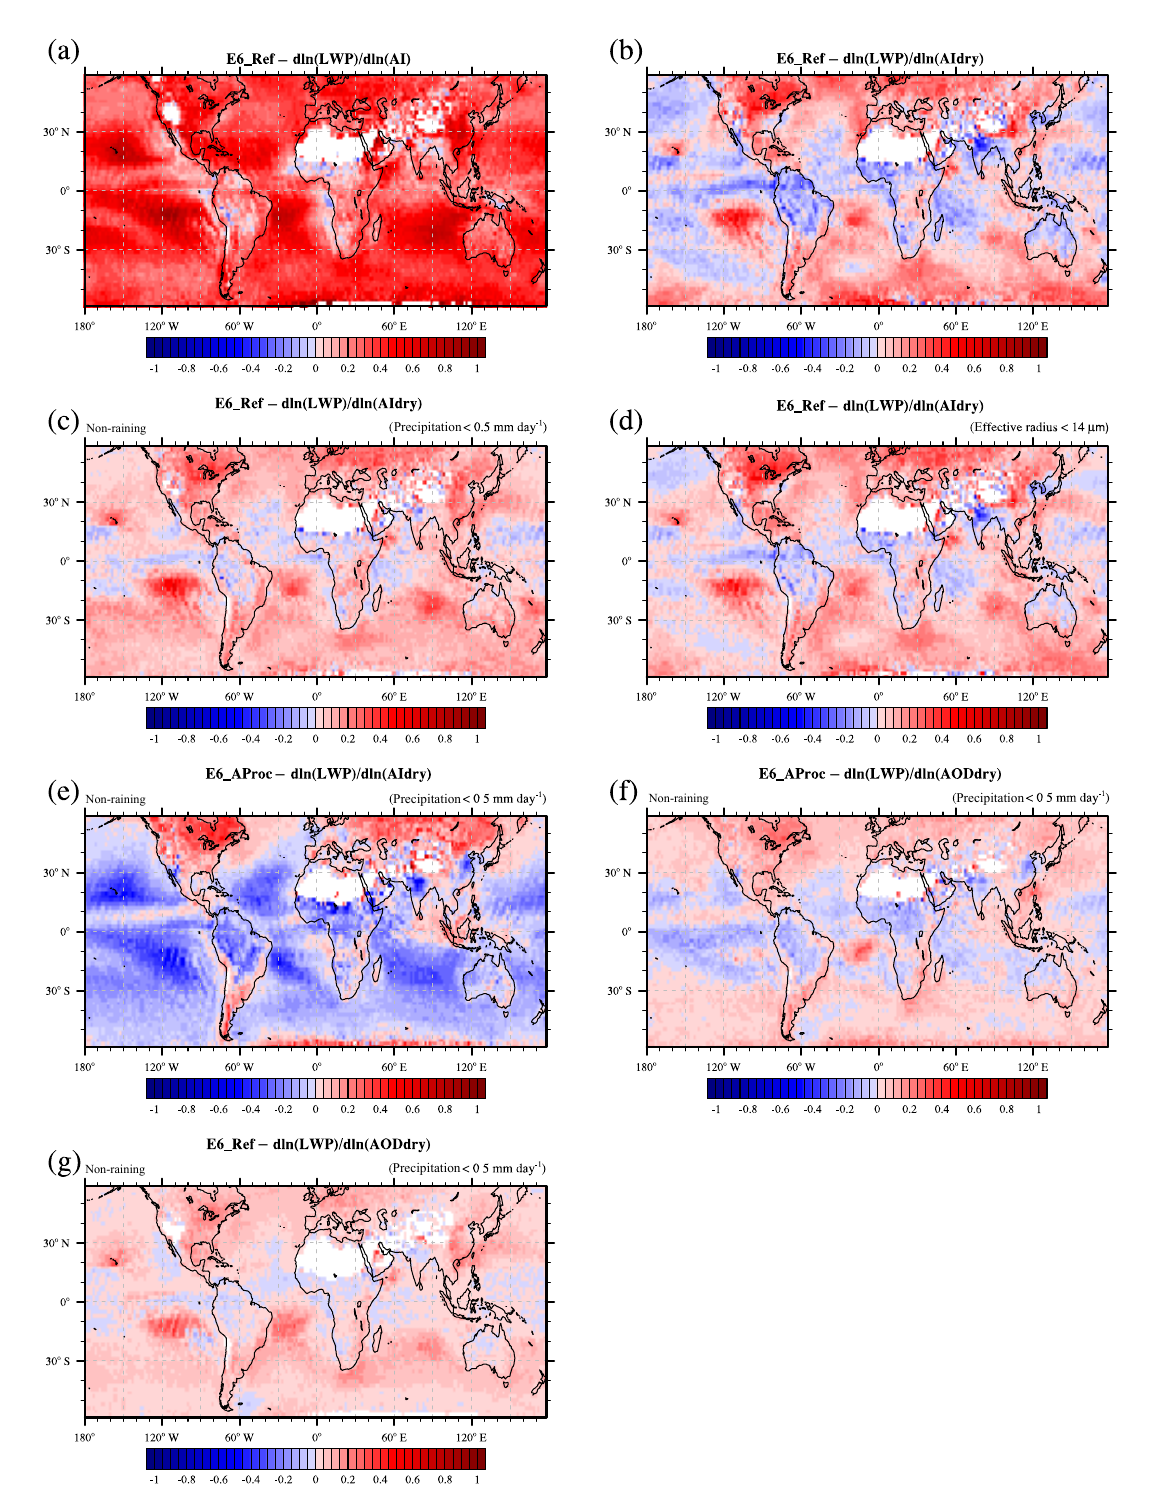
Figure 2. Susceptibility of LWP to changes in AI or AOD for ECHAM6-HAM2 (E6_Ref and E6_AProc) when low liquid clouds and aerosol are present during the simulation period 1995–2012 between 60 ◦ N and 60 ◦ S. (a) Response in E6_Ref to AI for all scenes, (b) the same as in (a) but for dry AI, (c) same as in (b) but only for non-raining scenes (precipitation<0.5mmday − 1 ) , (d) same as in (c) but with a different definition for non-raining scenes ( R e <14µm), (e) same as in (c) but for E6_AProc, (f) same as in (e) but for dry AOD instead of dry AI, (g) same as in (f) but for